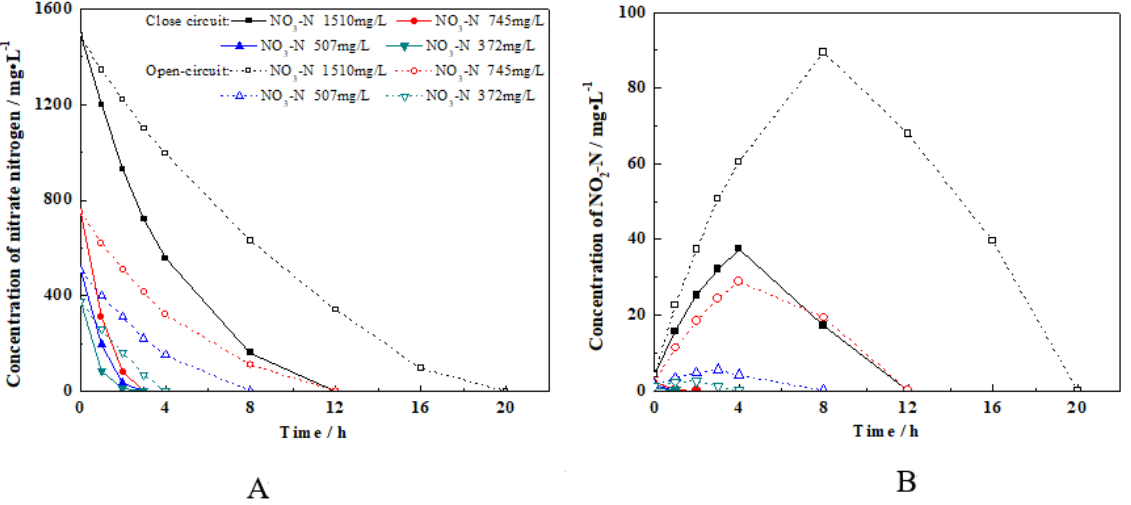
Figure 4. Changes of total nitrogen concentration ( A ) and nitrite nitrogen concentration ( B ) under open-circuit/closed-circuit.